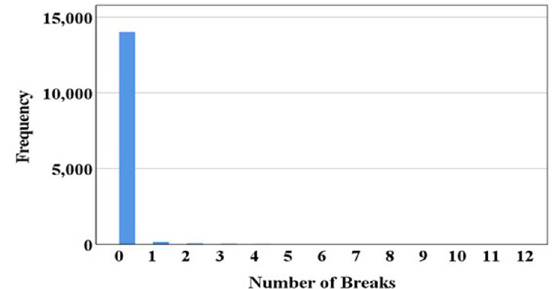
Fig. 2 Frequency of number of breaks in a WDN (imbalanced dataset) (Data source: https:// open- kitch energ is. opend ata. arcgis. com/ datas ets/ water- main- breaks/ explo re? locat ion 2C- 80. 434081% 2C12. 12 and https:// open- kitch energ is. opend ata. arcgis. com/ datas ets/ water- mains/ explo re? locat ion 2C- 80. 474206% 2C12.